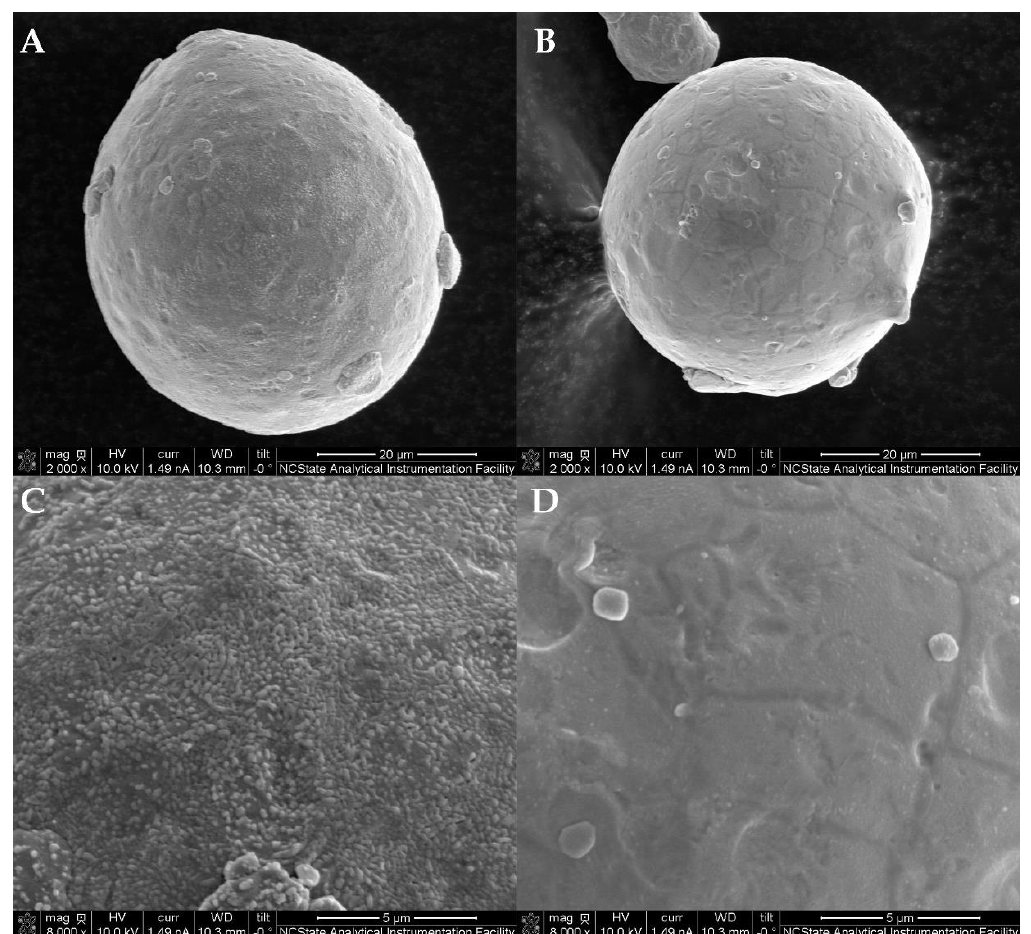
Figure 7. Representative low and high magnification scanning electron micrographs of untreated and hydrogen-treated MO-Cu powder. ( A ) Low magnification and ( C ) high magnification of untreated hydrogen-treated MO-Cu powder; ( B ) Low magnification and ( D ) high magnification of hydrogen-treated MO-Cu powder.